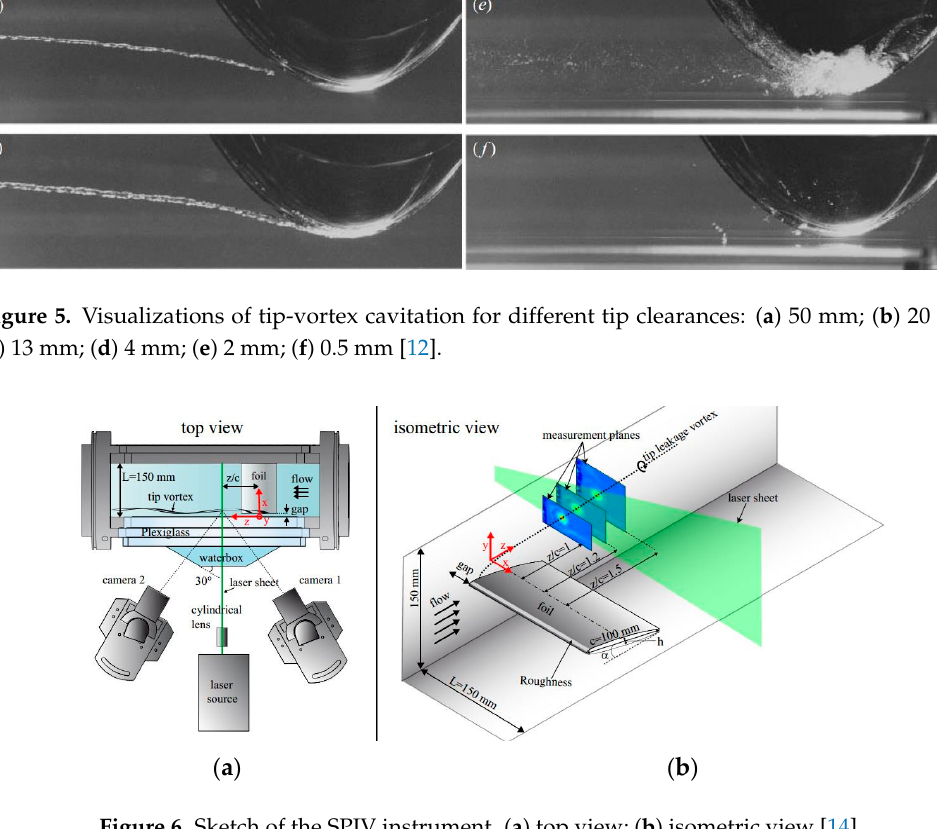
Figure 5. Visualizations of tip-vortex cavitation for different tip clearances: ( a ) 50 mm; ( b ) 20 mm; ( c ) 13 mm; ( d ) 4 mm; ( e ) 2 mm; ( f ) 0.5 mm [12].